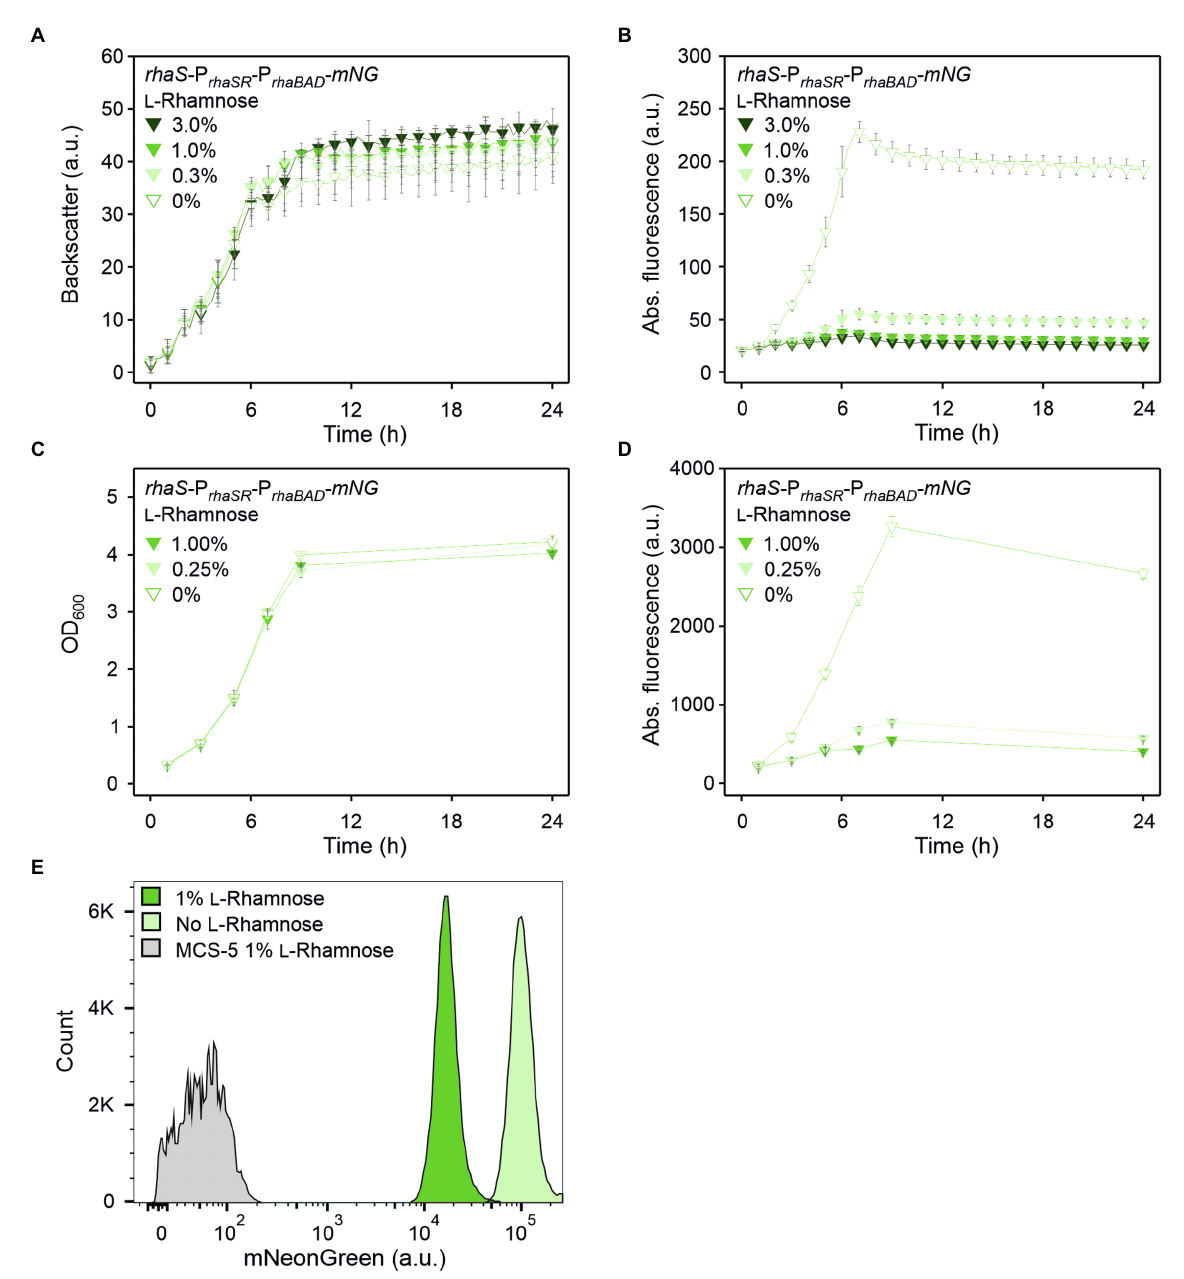
illustrates the responsiveness of both promoters toward low l-rhamnose concentrations (Figure 6). While the absolute repression of both promoters was similar and down to 10% of